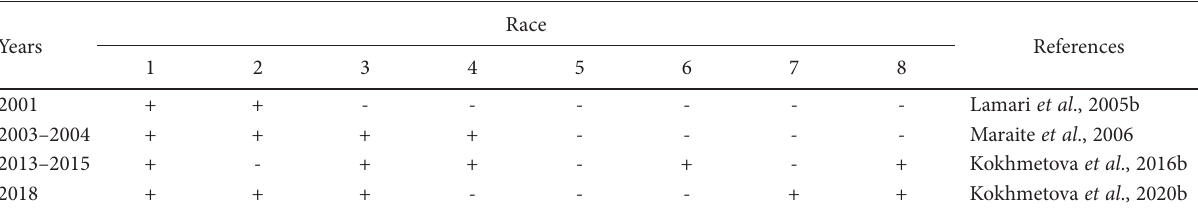
Table 1. The frequency of occurrence of P. tritici-repentis races in